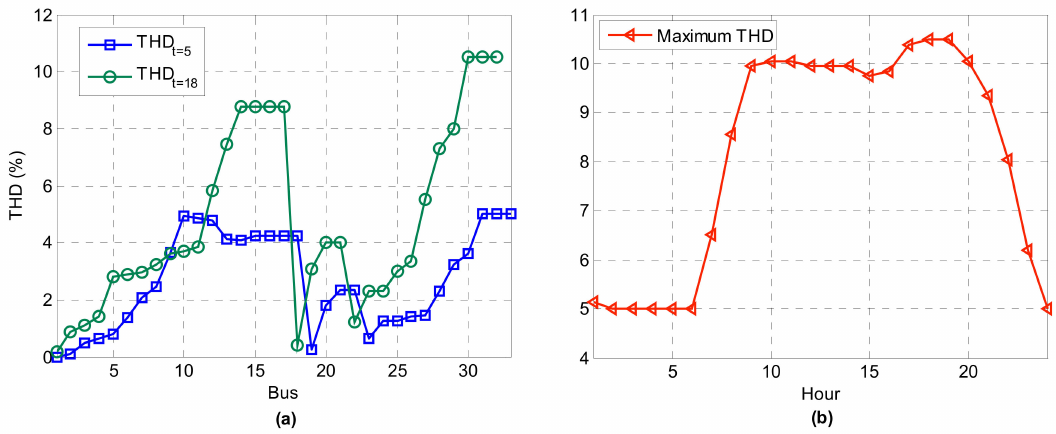
Figure 9. Case II. ( a ) Voltage THD for all buses at t = 5 and t = 18 and ( b ) maximum voltage THD of all buses at each hour.